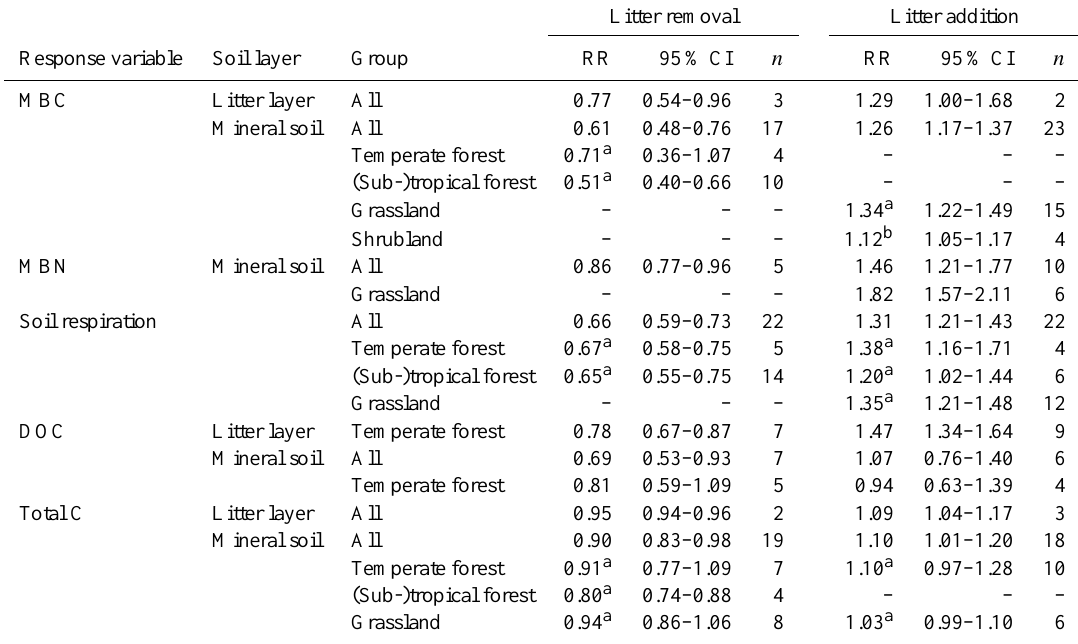
Table 2. Effects of litter removal and litter addition on soil carbon cycling parameters of different ecosystems, where MBC is microbial biomass carbon, MBN is microbial biomass nitrogen, and DOC is dissolved organic carbon. For each response variables, the responses of the ecosystems denoted by different superscript letter differed significantly ( P < 0 .